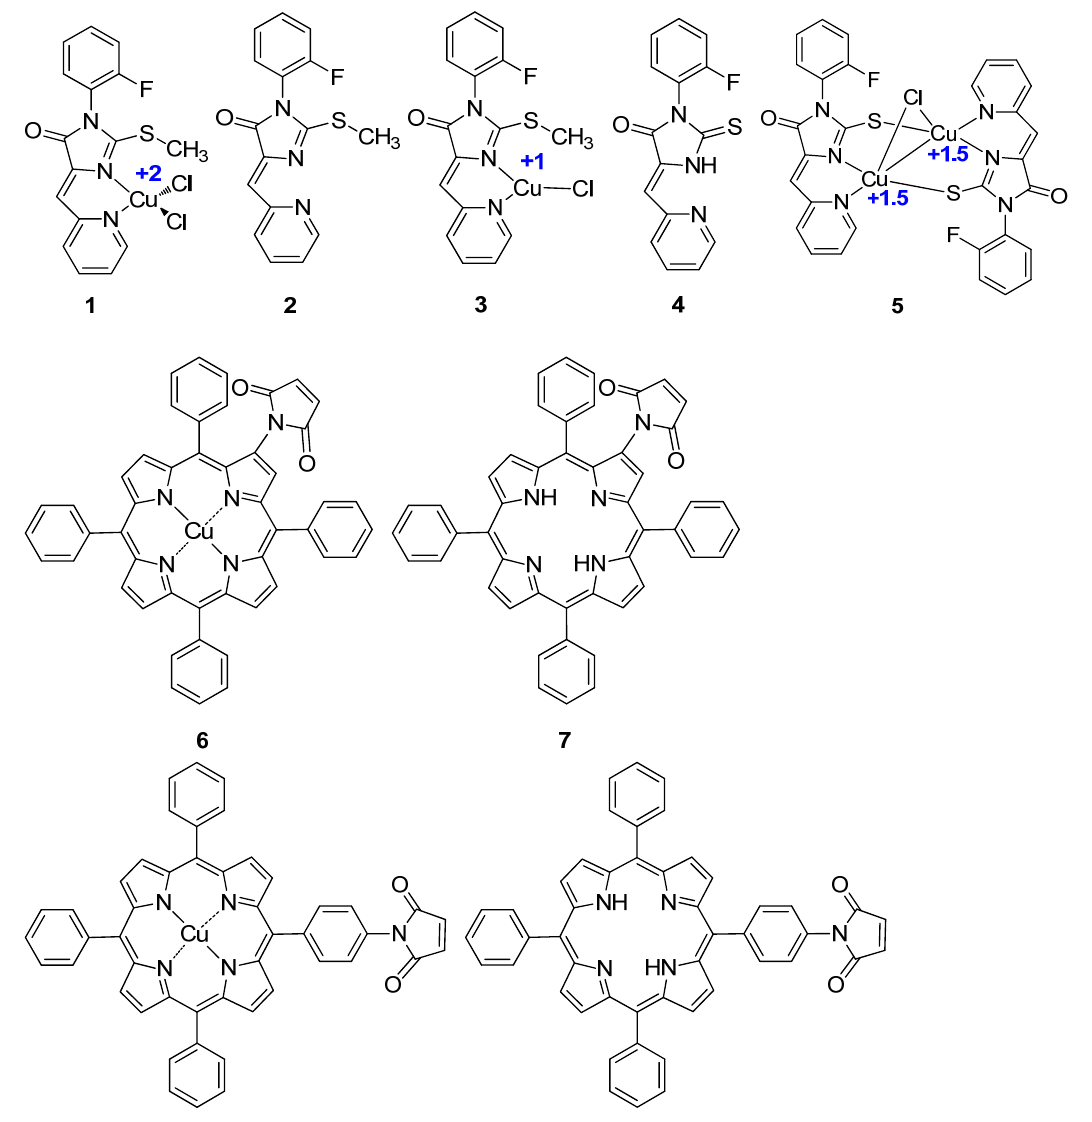
Table 2. Sensitization of HCT116 cells to Cu–organic compounds by NAC.